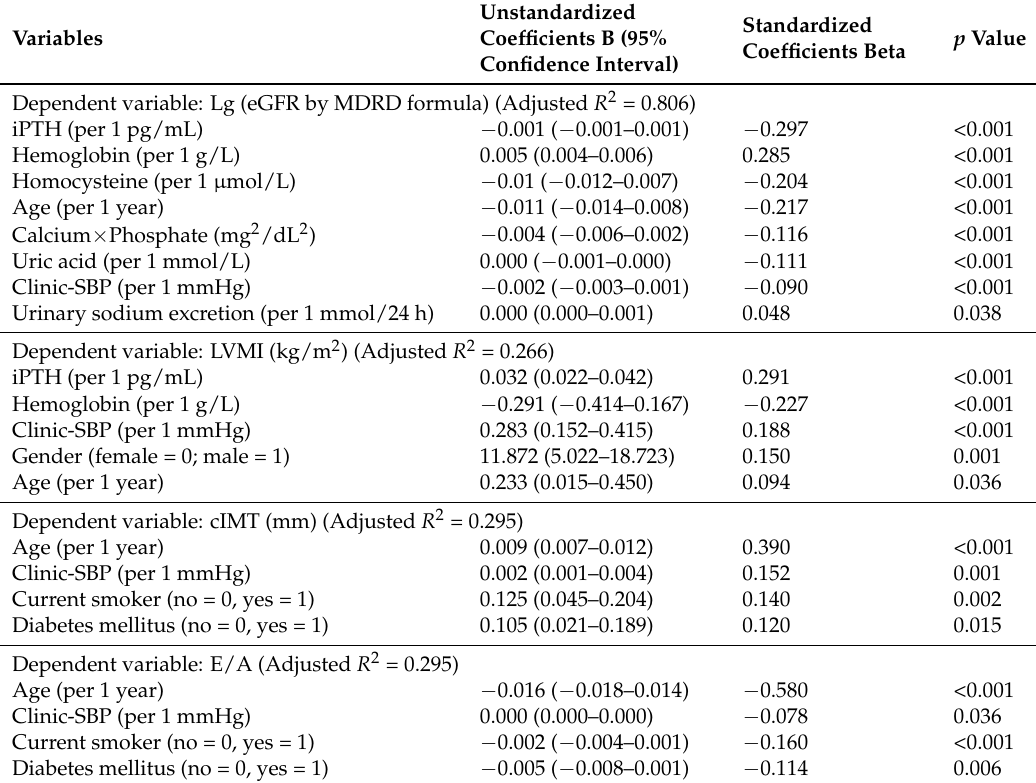
Table 3. Multivariable linear regression analysis for Lg(eGFR), LVMI, E/A, cIMT. Variables